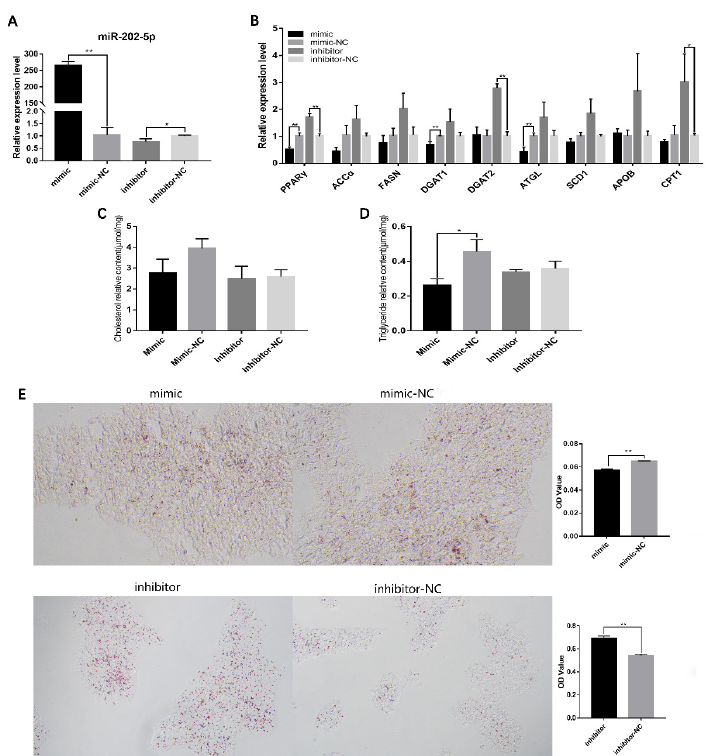
Figure 2. MiR-202-5p inhibits lipid deposition of goose granulosa cells. ( A ) effects of the mimic and inhibitor on expression of miR-202-5p, ( B ) effects of the interference or overexpression of miR-202-5p on the expression of genes related to lipid metabolism, ( C , D ) effect of the interference or overexpression of miR-202-5p on the content of TG and total CH (TG: triglyceride, CH: cholesterol), and ( E ) effect of the interference or overexpression of miR-202-5p on lipid deposition in hGCs. * p < 0.05, ** p < 0.01.